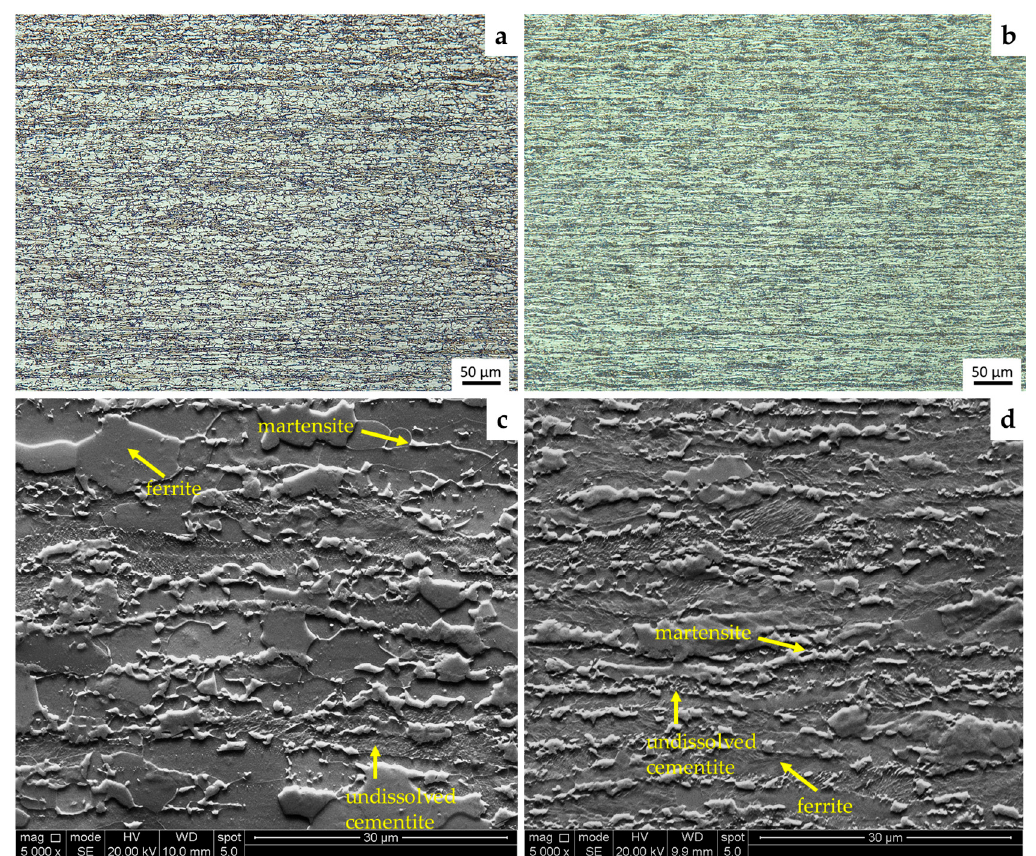
Figure 3. ( a ) OM image of the CH sample, ( b ) OM image of the UFH sample, ( c ) SEM image of the CH sample, and ( d ) SEM image of the UFH samples. Both microstructures consist of martensite islands and undissolved pearlitic colonies embedded into a ferritic matrix.